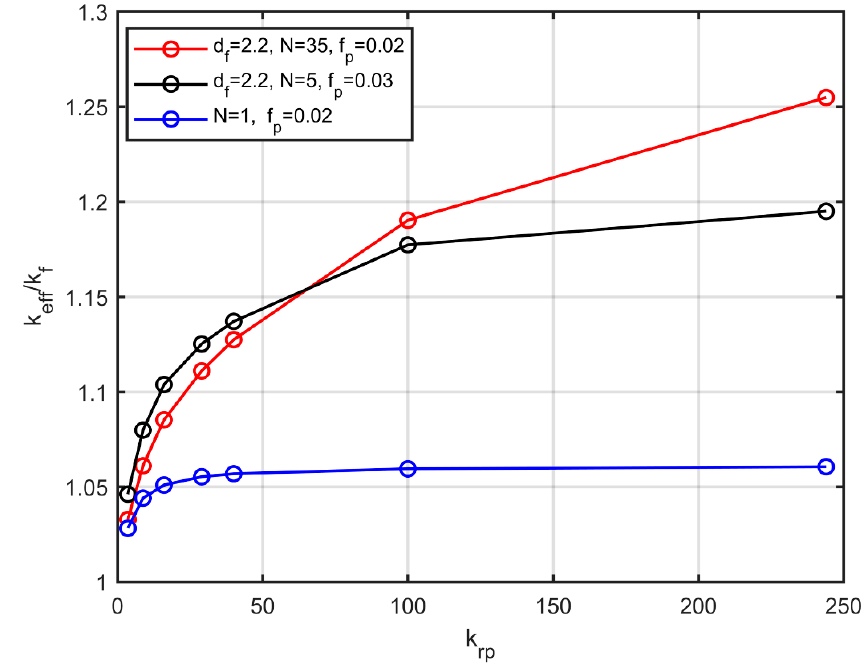
Figure 12. Thermal conductivity as a function of the ratio of the conductivity of the particles and that of the base fluid, for three characteristic cases. of the base fluid, for three characteristic